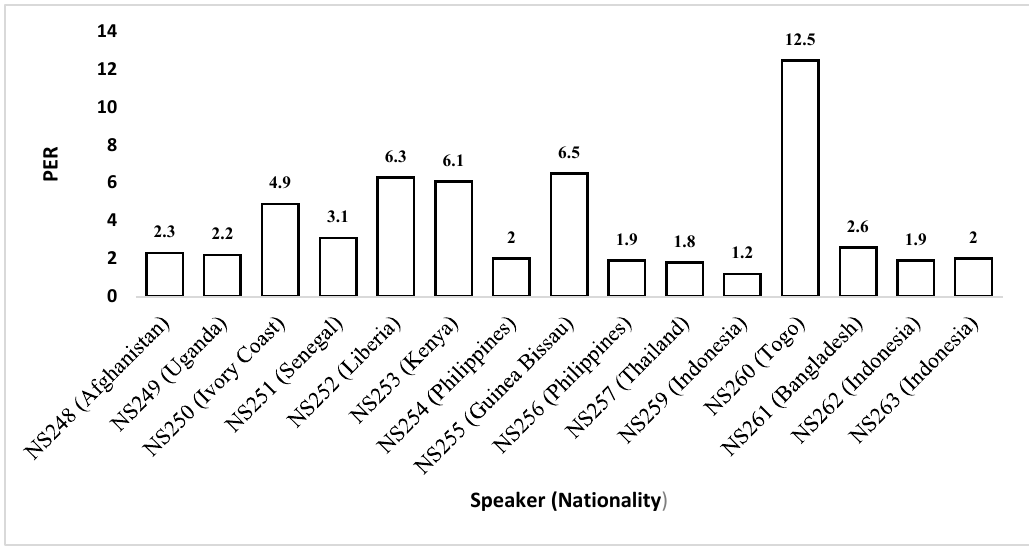
Figure 6. PER for each speaker using our best model: YOLO-CNN-RNN-CTC.